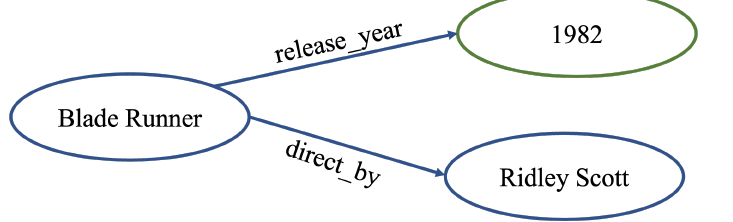
Figure 1. A triple example with a property edge “release_year” and a relation edge,